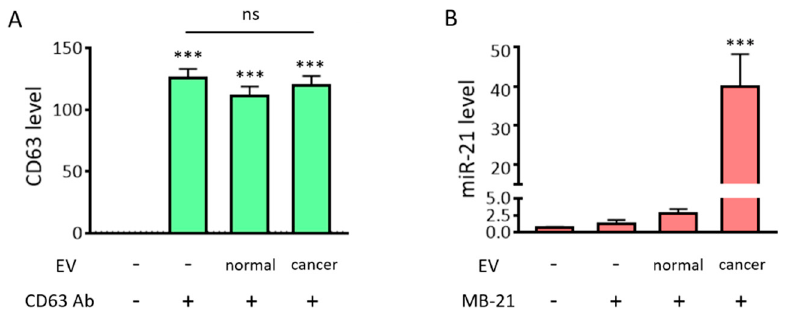
Figure 4. Fluorometer-based detection of EV miRNAs and surface protein markers. Simultaneous in situ detection of EV surface protein (CD63) and miRNA (miR-21) was tested. Fluorescent signals were assessed using a fluorometer. ( A ) Fluorescent intensities from the fluorescence dye labelled-CD63 antibody, in the absence/presence of EVs, were assessed. There was a drastic increase in the fluorescent signals from the CD63 antibody, regardless of the presence/absence of EVs and type, which suggests that the unbound free CD63 antibody must be removed for specific EV CD63 detection. ( B ) The fluorescent intensities from MB-21, in the absence/presence of EVs, were assessed. There was no significant difference in fluorescent signals upon addition of MB-21 in the absence of EVs. This could be attributed to the self-quenching ability of MB in the absence of target miRNA. The detection signal increased when MB-21 was incubated with normal EVs, and further increased upon incubation of MB-21 with cancer EVs. All values are expressed as mean ± SD (*** p < 0.001; ns: Not significant; n = 3–4).